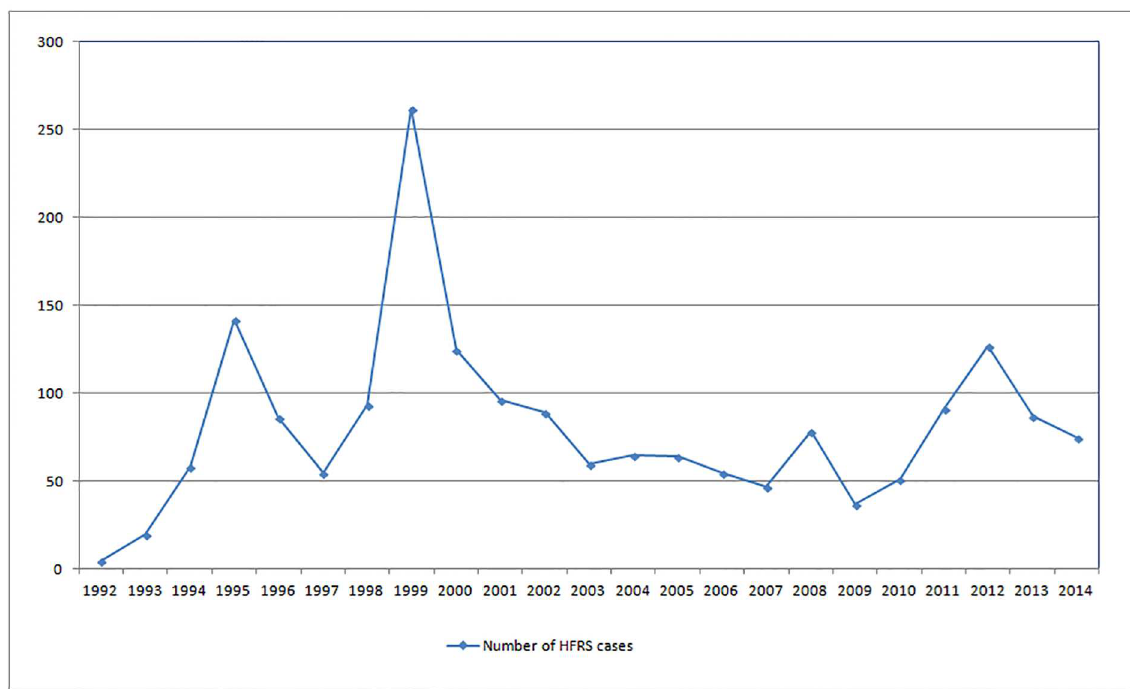
Fig 2. The number of HFRS cases in Jiaonan from 1992 to